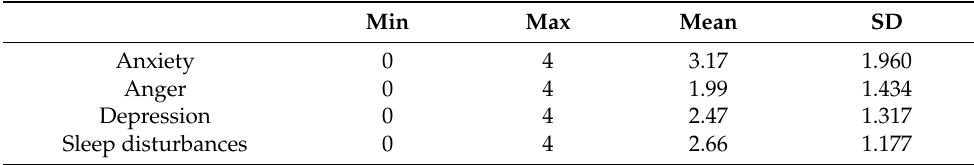
Table 1. IDPs’ mean and standard deviations of mental health